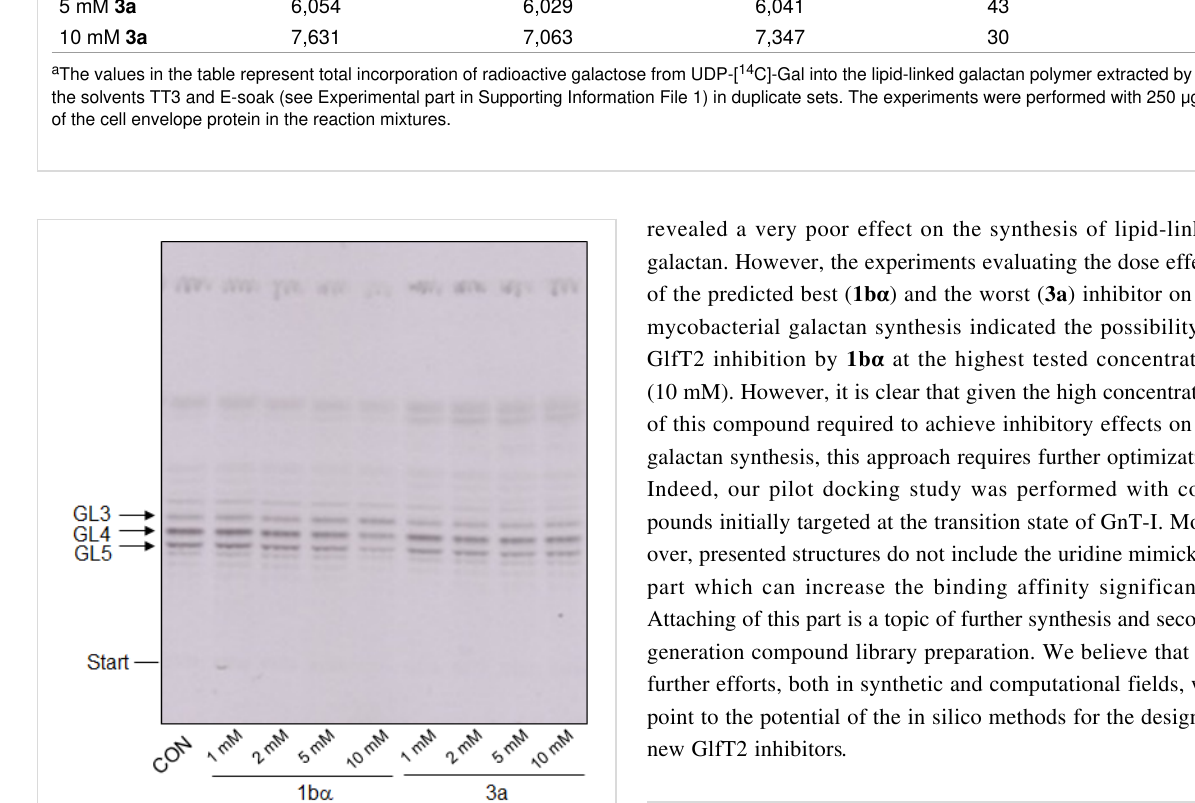
ence of 10 mM 1b α the predominant bands are GL3 and GL4, the products of GlfT1, which could point to a GlfT2